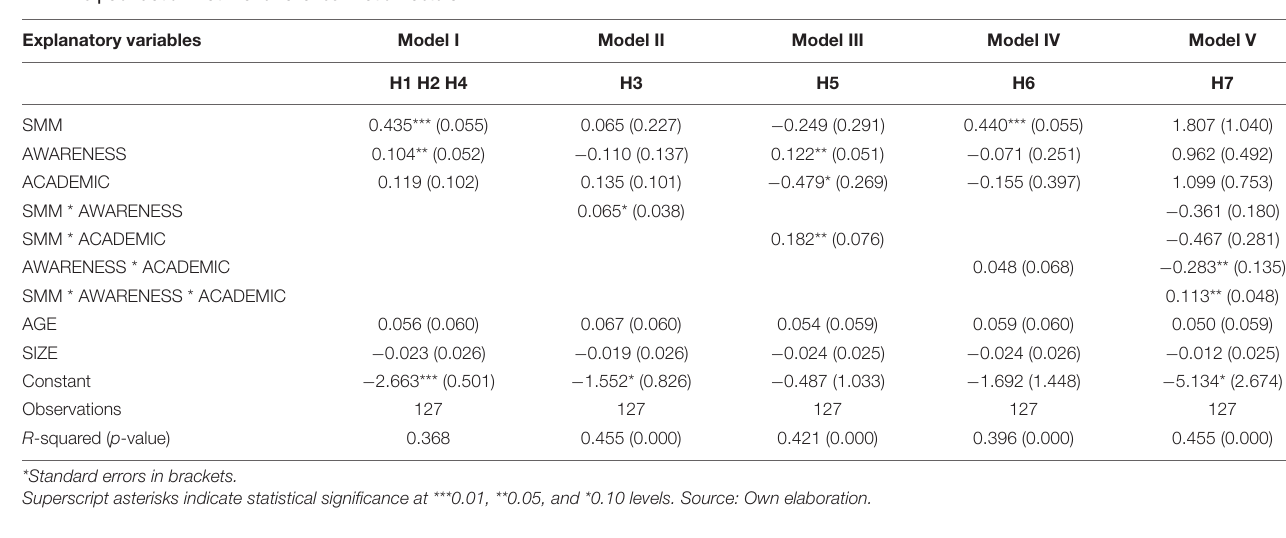
TABLE 3 | Correlation matrix and variance inflation factors*.